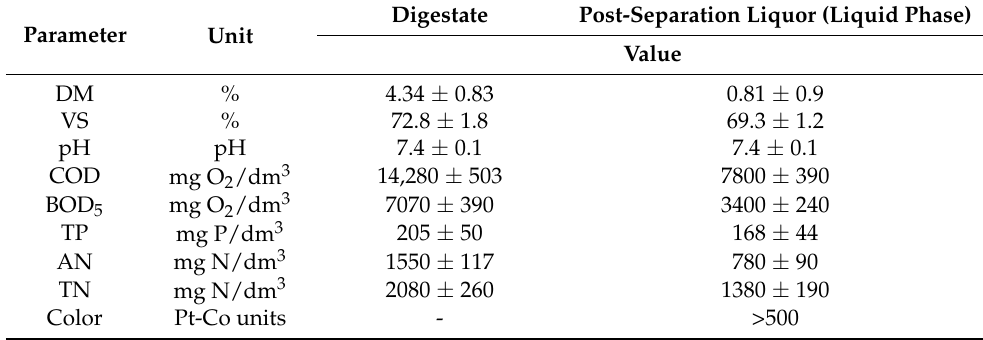
Table 1. Parameters of the digestate and post-separation